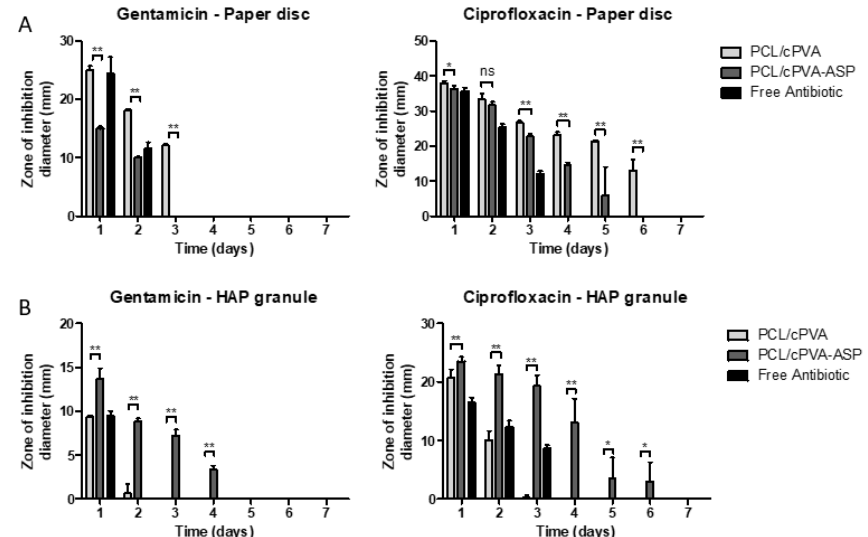
Figure 8. ( A ) Zone of inhibition established by 1 mg of PCL / cPVA or PCL / cPVA-ASP with antibiotic (GM-AOT, left and CF, right) load or the respective free antibiotic on paper discs ( n = 4). ( B ) Zone of inhibition around a HAP granule exposed to GM-AOT or CF loaded microsphere dispersions or free antibiotic ( n = 4). All GM-AOT loaded microspheres were tested against S. aureus while CF loaded microspheres were tested against E. coli . Error-bars represent standard deviations of quadruplicate measurements. Statistical test was a two-sample Student’s t -test ( α = 0.01) with the following legend: * = p < 0.01, ** = p < 0.001, ns = p < 0.01).